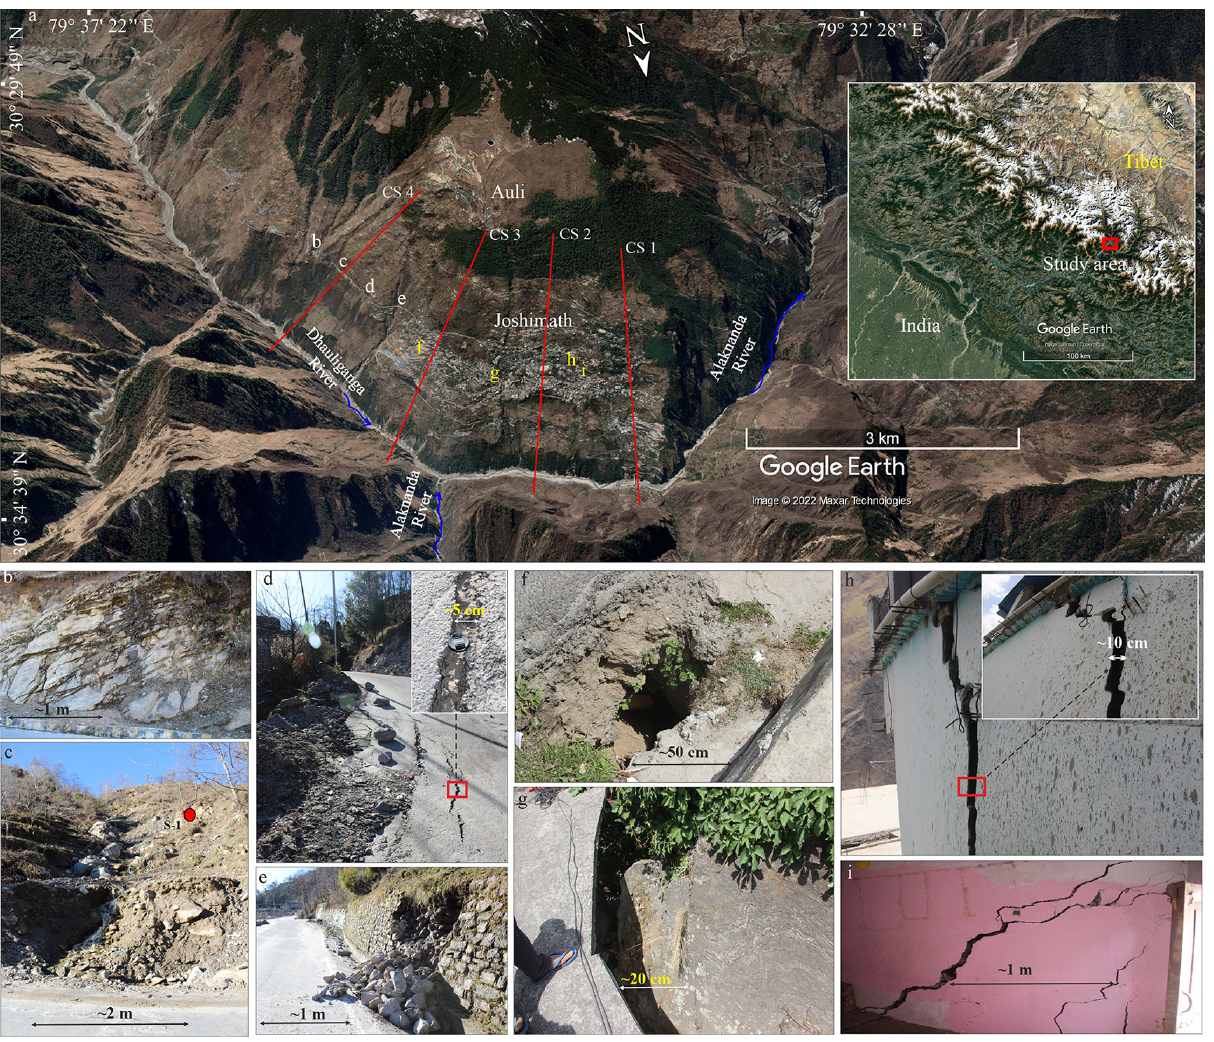
Figure 1. Field observation of Joshimath. (a) Location of Joshimath with the inset highlighting its position in the NW Himalaya. © Google Earth for panel (a) . CS 1 to CS 4 mark the position of 2D slope sections used for the slope stability evaluation. (b) Rock mass exposure and (c) natural drainage (Nala) through the hillslope. Position of soil sampling site (S-1), (d) cracks and displacement in the road, (e) bulging and collapse of retaining wall, (f–g) displaced hillslope material and hence displaced pavements, and (h–i) cracks in houses. Picture (f–i) courtesy: Atul